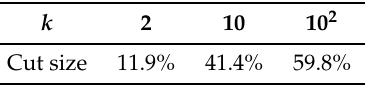
Table 4. Cut sizes produced by our algorithm on Friendster (ratio of cut edges to the total number of edges), where k denotes the number of